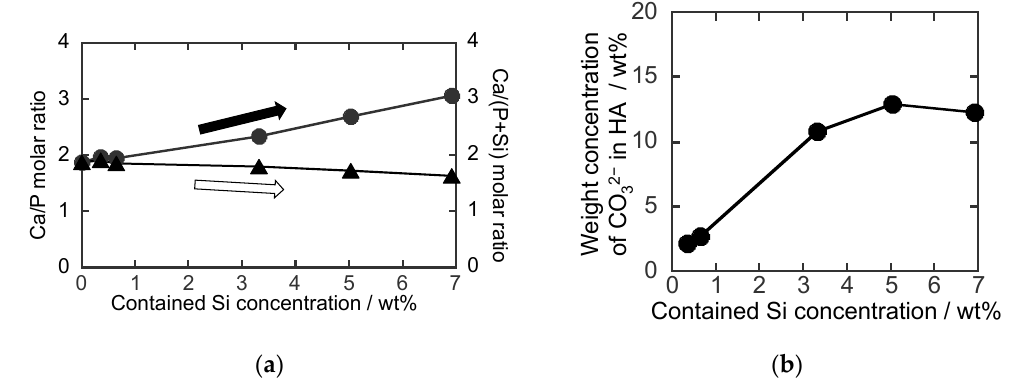
Figure 1. ( a ) Resultant molar ratios of the ( ● ) Ca to P (Ca/P) and the ( ▲ ) Ca to (P + Si) (Ca/(P + Si)) and ( b ) carbonate weight concentration in the SiHA particles. Here, the contained Si concentrations were 0.35, 0.65, 3.32. 5.03 and 6.92 wt% for 0.8 SiHA, 1.5 SiHA, 4.0 SiHA, 6.0 SiHA and 8.0 SiHA.